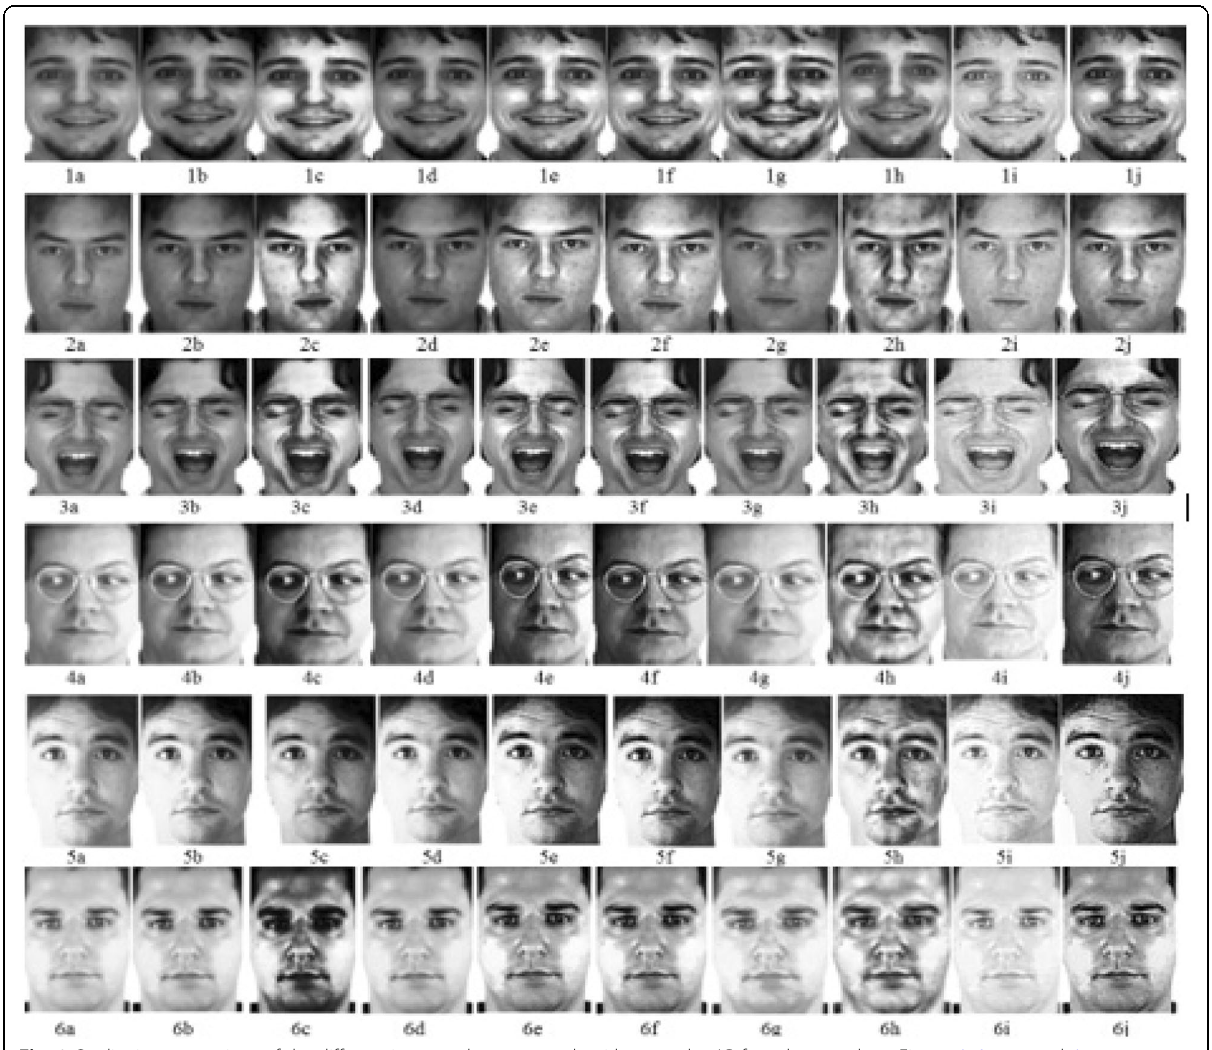
Fig. 9 Qualitative comparison of the different image enhancement algorithms on the AR face dataset where Figs. 1, 2, 3, 4, 5, and 6 represent images of different subjects respectively. a – j denote the methods labeled as a original, b LCC, c HE, d IIA, e M_PSO, f M_GA, g BDPFHE, h CLAHE, i LLIE, and j